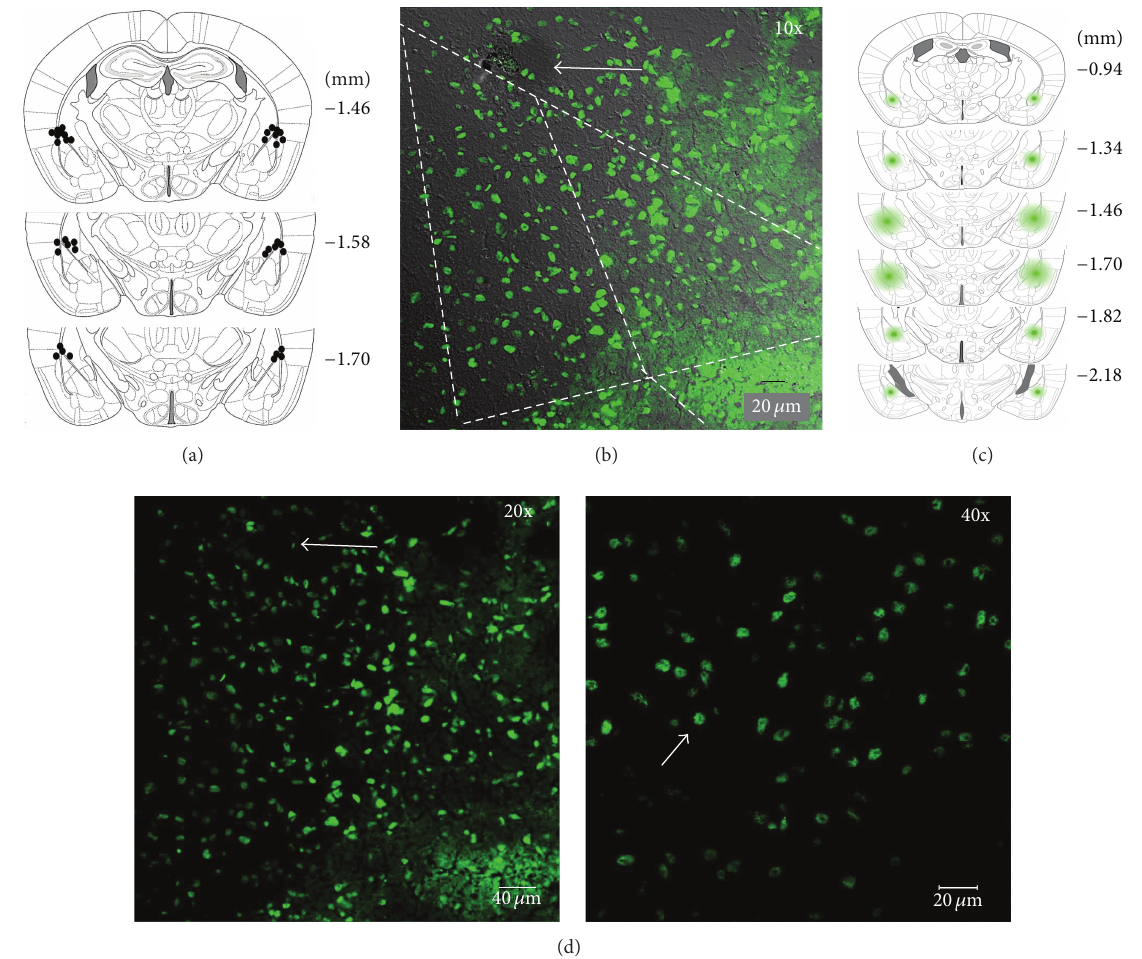
Figure 3: Distribution of cannula placements and RAG1 antisense oligonucleotide diffusion within the amygdala. After behavioral treatments with RAG1 antisense or random oligonucleotides, animals were microinfused the next day with thionine to verify cannulae injectors’ placement. Another set of animals was used to observe FITC-labeled RAG1 antisense diffusion. (a) Schematic representation of the amygdala at different rostrocaudal planes illustrating the position of cannulae injectors determined by thionine microinfusion. Injector tips for each cannula are represented by dark spots. (b) FITC- RAG1 antisense diffusion within the amygdalar complex; arrow indicates the injector’s tip. (c) Schemes of coronal sections showing the diffusion of FITC- RAG1 antisense diffusion into the amygdala of animals decapitated 3 h after fluorescent oligonucleotide infusion. FITC- RAG1 antisense diffusion is represented by green shading from anterior to posterior areas of the amygdalar complex. The numbers in (a) and (c) indicate the distance from bregma in millimeters. A total of 4 mice were used in these studies. (d) Photomicrograph at higher magnification of FITC- RAG1 antisense diffusion showed clearly incorporation into the cells (depicted by the arrows) within amygdalar